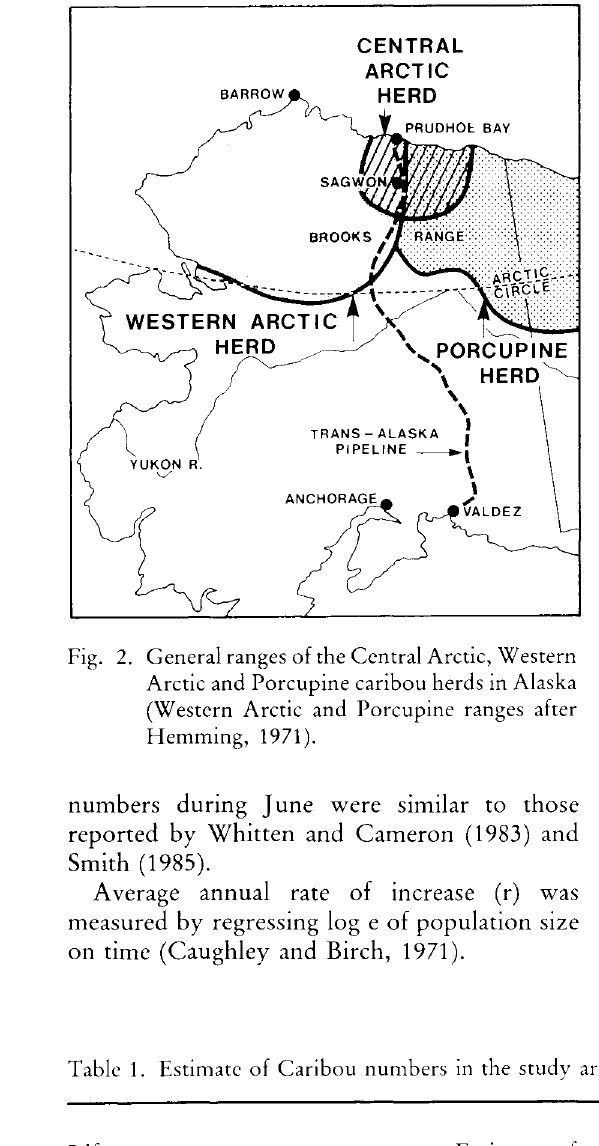
Table 1. Estimate of Caribou numbers in the study area based on 10% survey coverage.